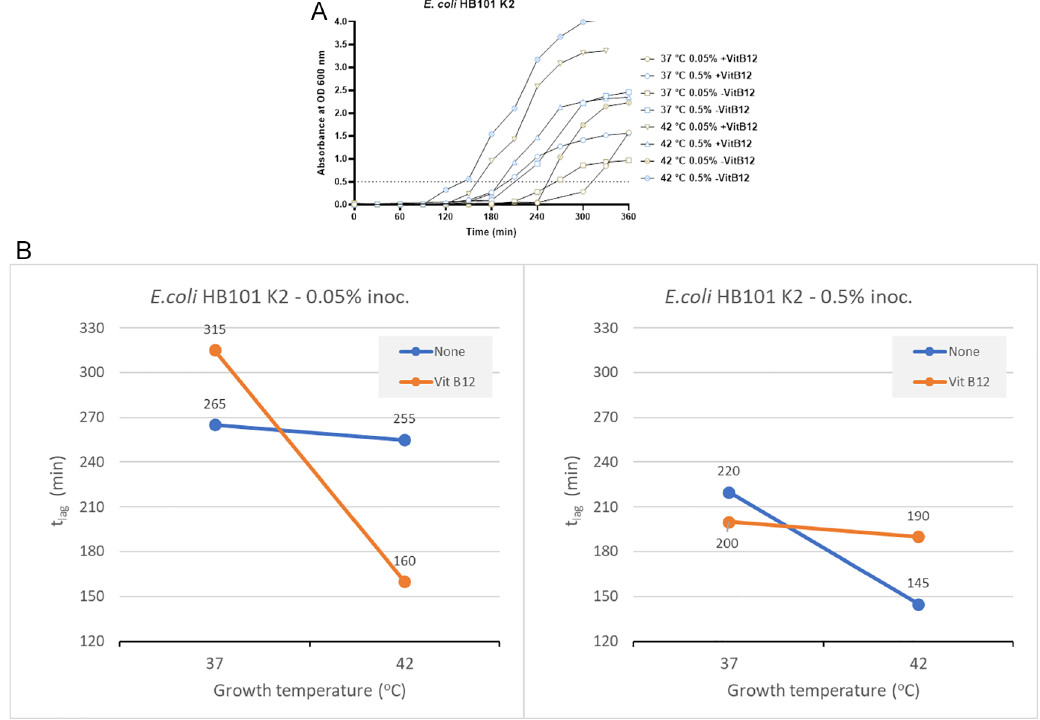
Figure 2. Results from E. coli HB101 K2 under different growth conditions, including inoculum size, temper- ature, and vitamin B12 supplementation. (A) Growth curves of E. coli HB101 K2 were obtained in three-factorial designs; at37 ° Cand42 ° C,inoculumsize0.05% and0.5%,withandwithout vitaminB12.Thedottedlineindicates OD 0.5 for estimating the t lag from curves. (B) Effect plot of E. coli HB101 K2 in minutes (t lag ) to reach optical density